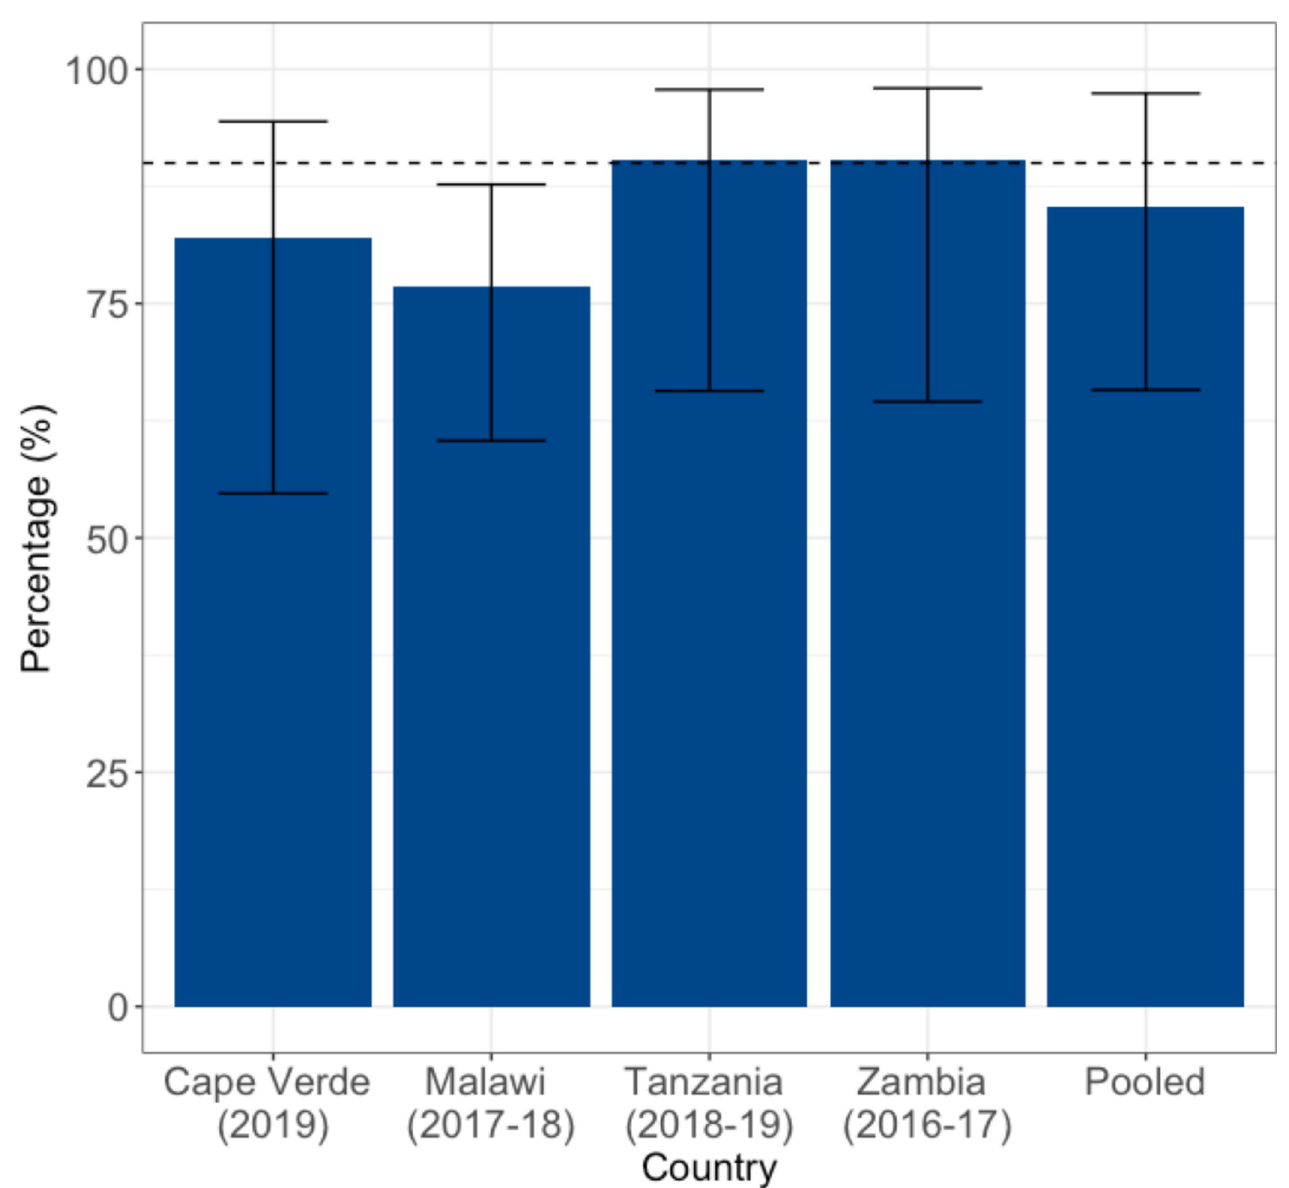
Fig 6. Reported pre-cancer treatment coverage among women with an abnormal or positive screening result. Country-level estimates are taken directly from the survey data. Pooled estimates are obtained from the model. The dotted blue line represents the 90% treatment goal set by the WHO. The height of the bars represents the median estimates and the error bars represent the 95% CrIs. CrI, credible interval; WHO, World Health